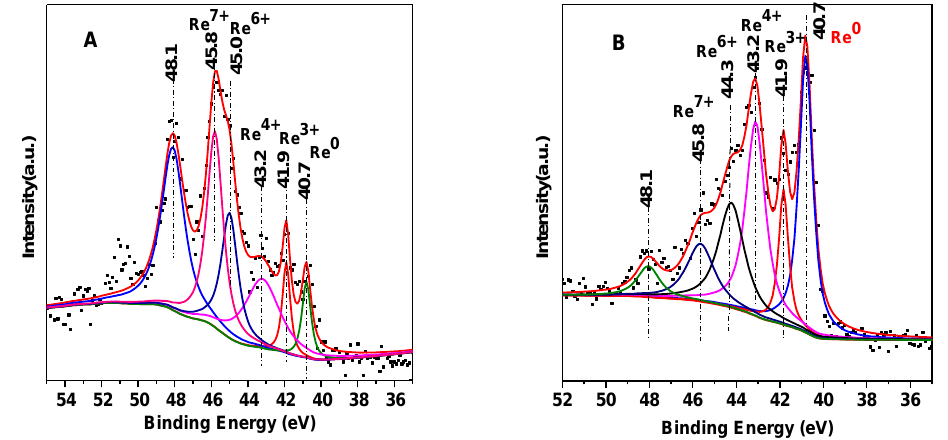
Figure 5. Two representative Re 4f XPS of ( A ) 15.8% Re / AC and ( B ) Ni-Re / AC (n Ni :n Re =